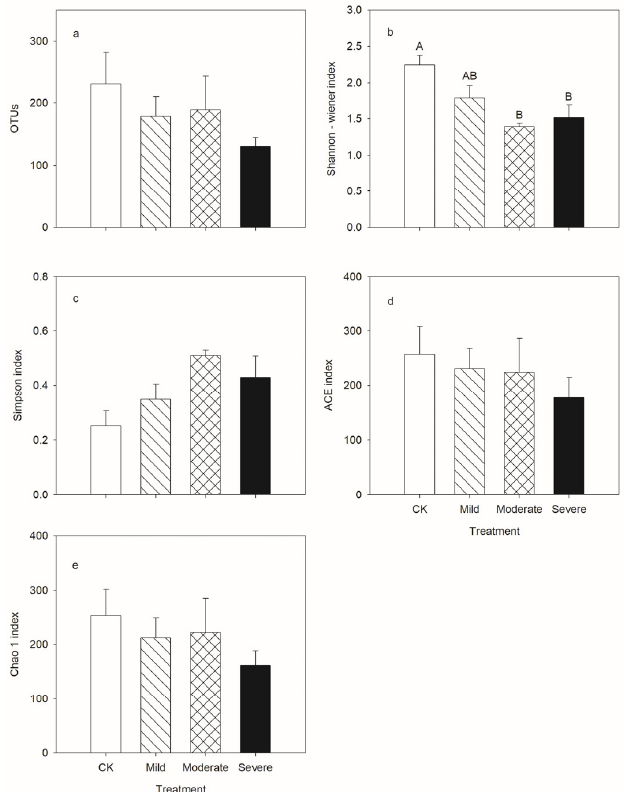
Figure 3. Effects of different levels of salt stress (CK, mild, moderate, and severe) on the endophytic fungal diversity of alfalfa, including the OTU number ( a ), Shannon–Wiener index ( b ), Simpson index ( c ), ACE ( d ), and Chao 1 estimator ( e ). Values are means ± SEs. Significant differences between different levels of salt stress are indicated by uppercase letters ( p < 0.05).